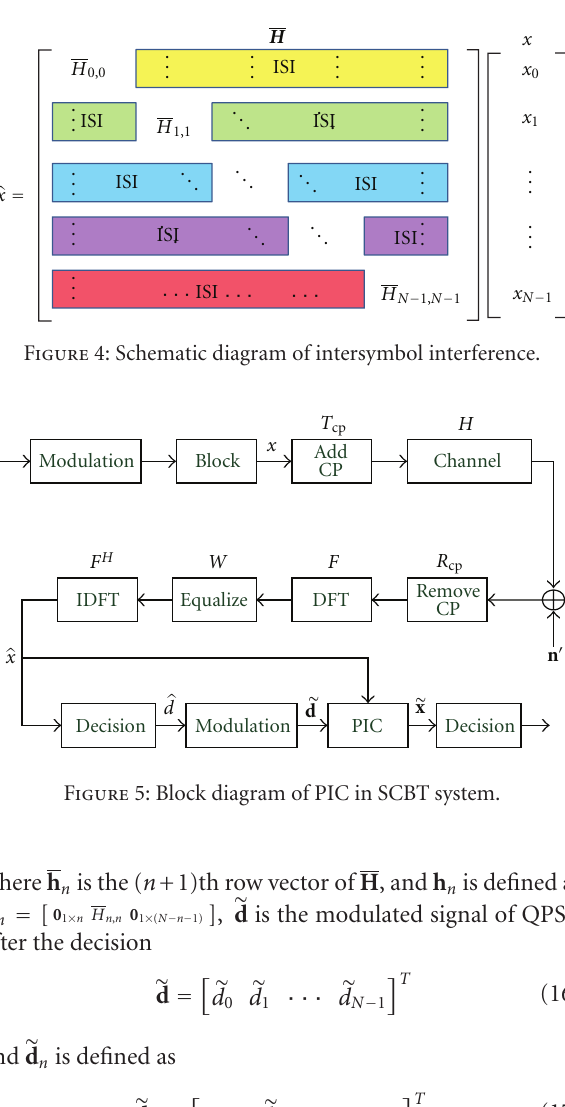
Figure 7: The illustration of partial selection matrix for partial PIC-